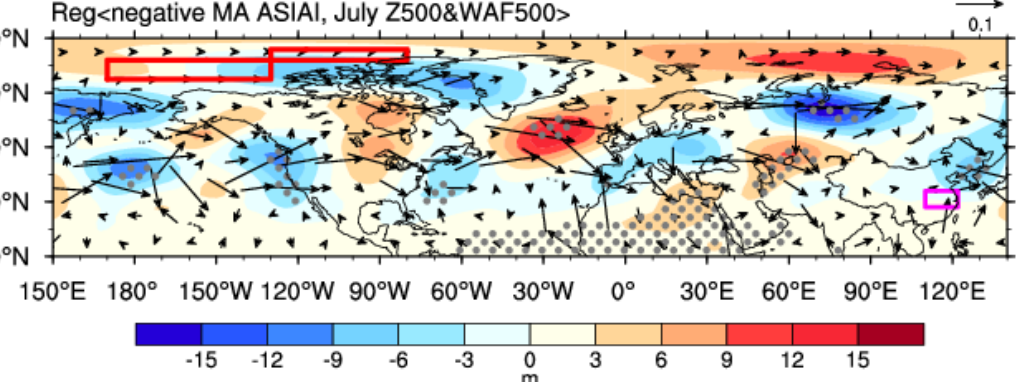
Figure 11. Regression map of July–mean Z500 (shading; unit: m) and 500 hPa horizontal WAF (vectors; unit: m 2 s − 2 ) onto the normalized negative MA–mean ASIAI for the period 1980–2016. Areas with significant values of Z500 exceeding the 95% confidence level are stippled. The magenta box denotes the research domain of the YHRB Meiyu region.